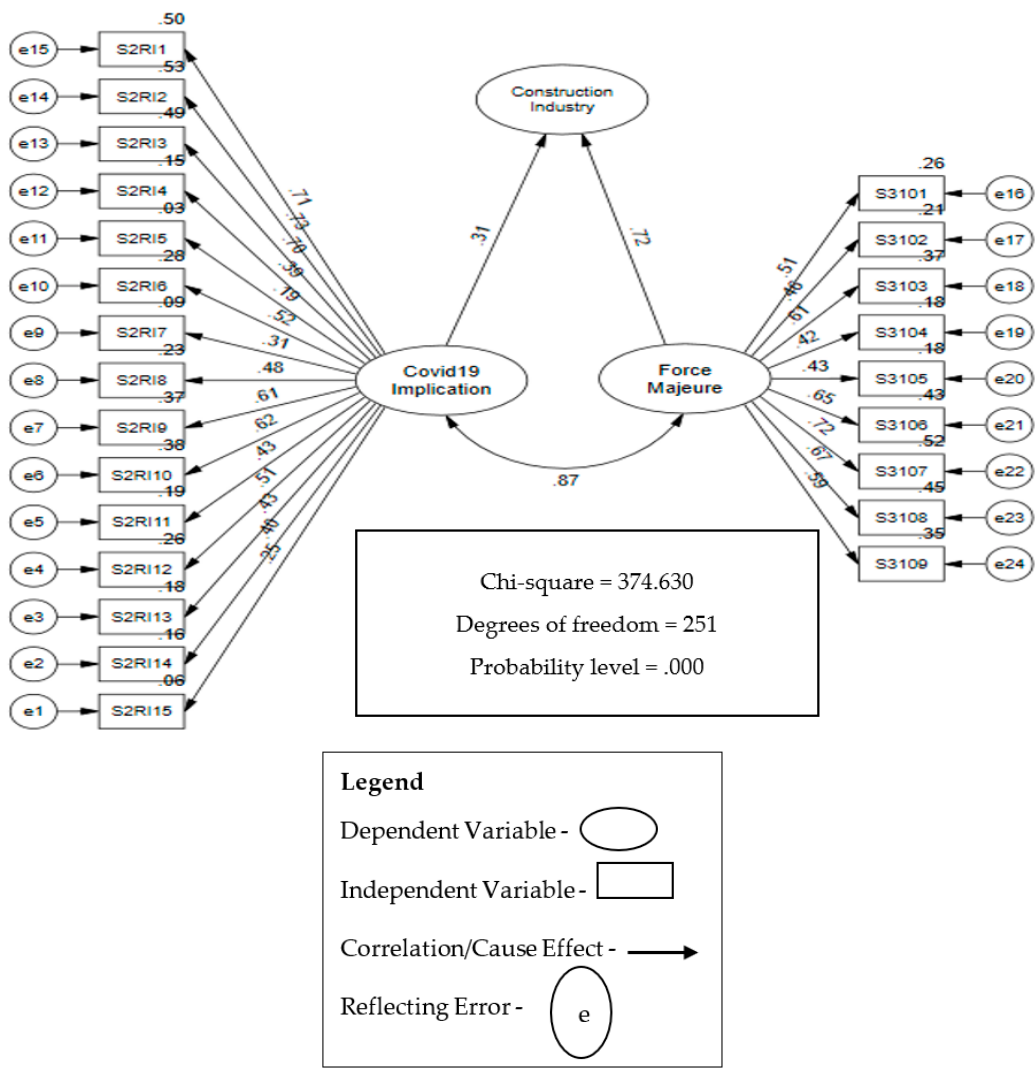
Figure 4. Unfit model.